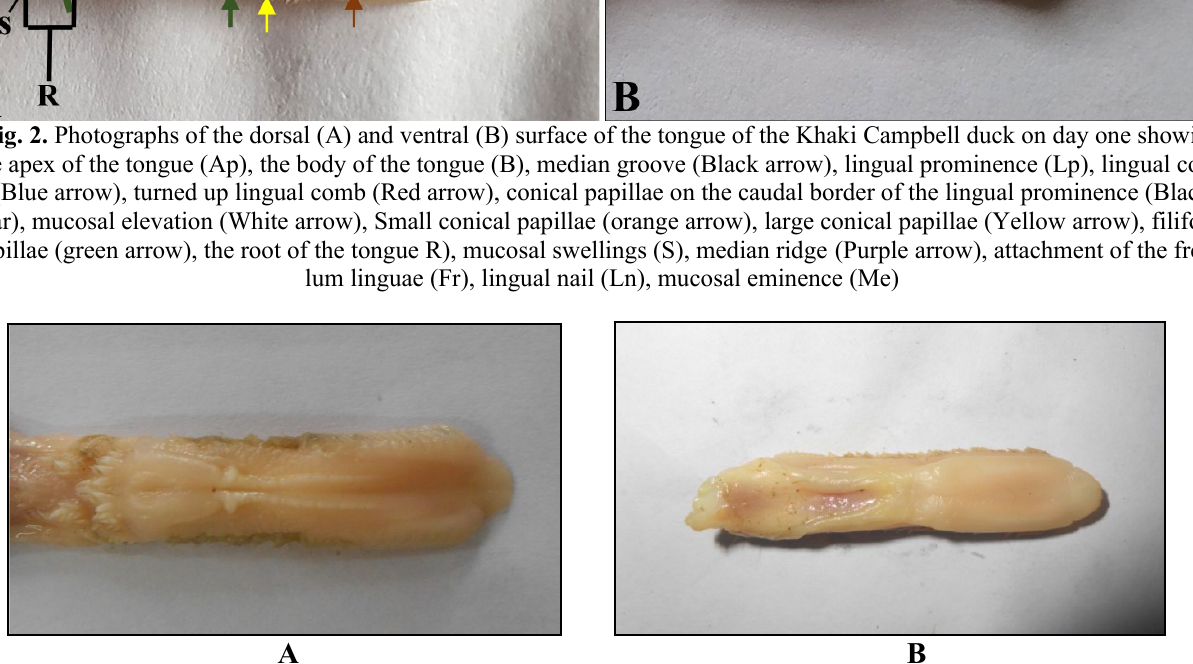
Fig. 3. Photograph of the dorsal (A) and ventral (B) surface of the tongue of the Khaki Campbell duck at one month of